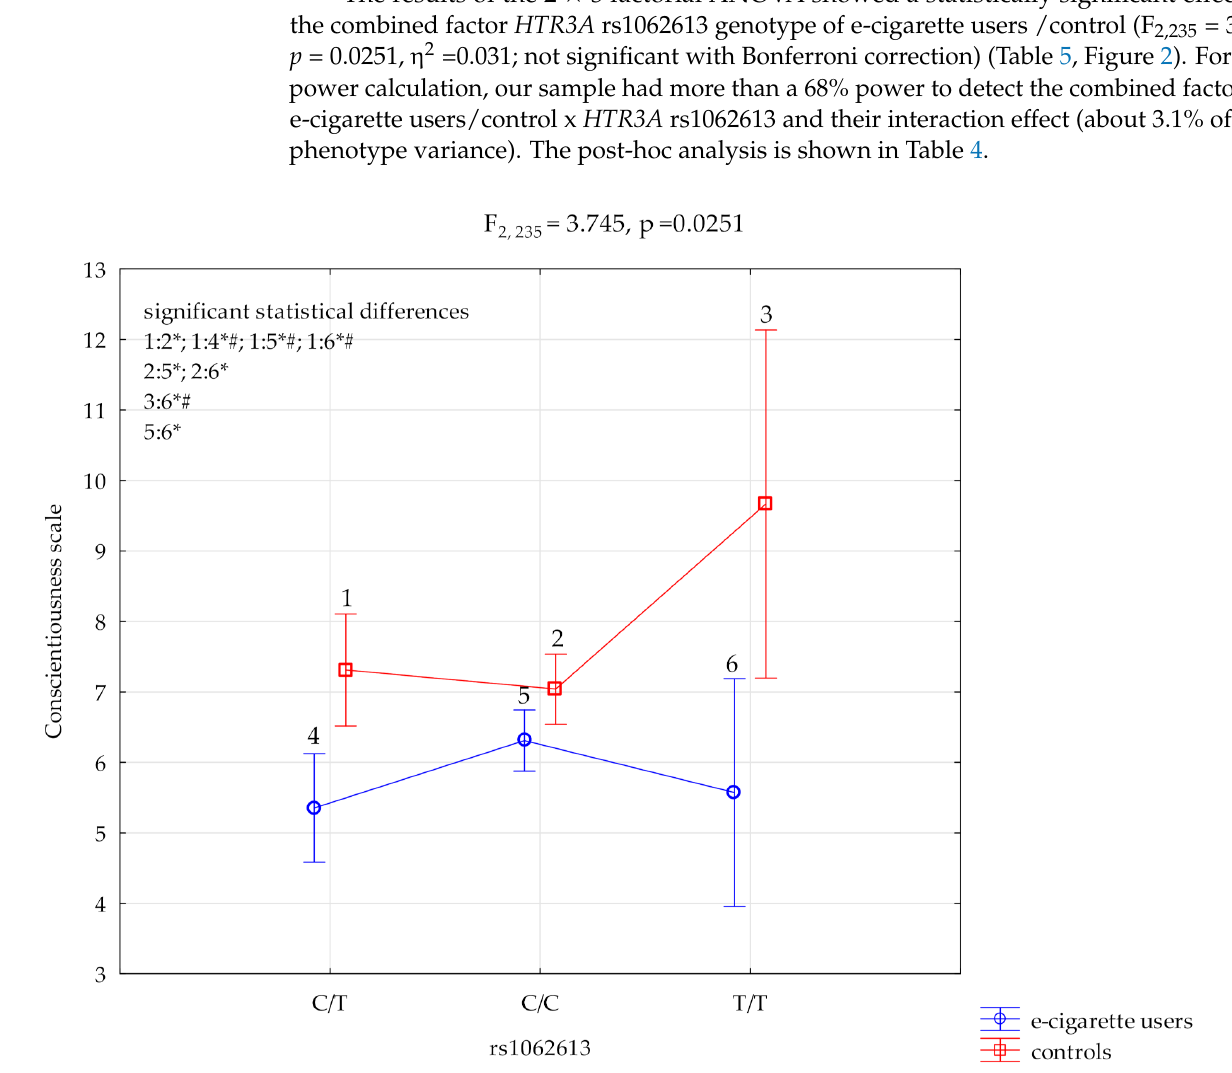
Figure 2. Interaction between e-cigarette users/controls, HTR3A rs1062613 and conscientiousness scale. * significant statistical differences, # Bonferroni correction was used, and the p value was reduced to 0.0083 ( p = 0.05/6 (number of statistical tests